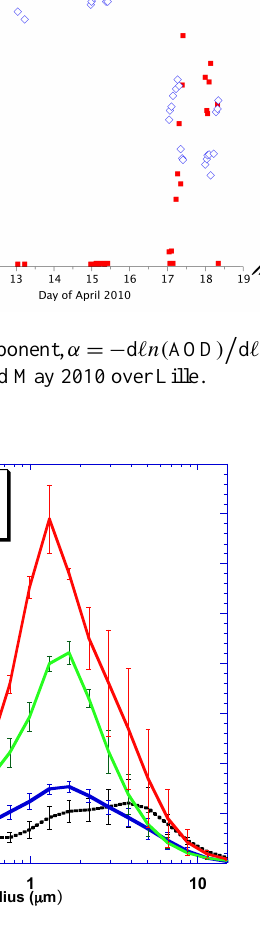
Fig. 3. Average size distributions (level 2) retrieved on 15, 17 and 18 April 2010. Error bars represent standard deviation and indicate time